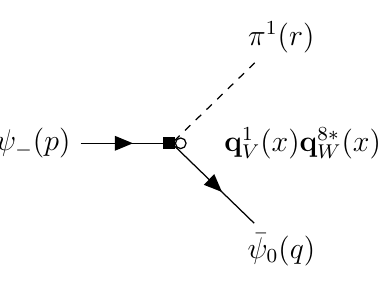
◦ is the vertice propor-